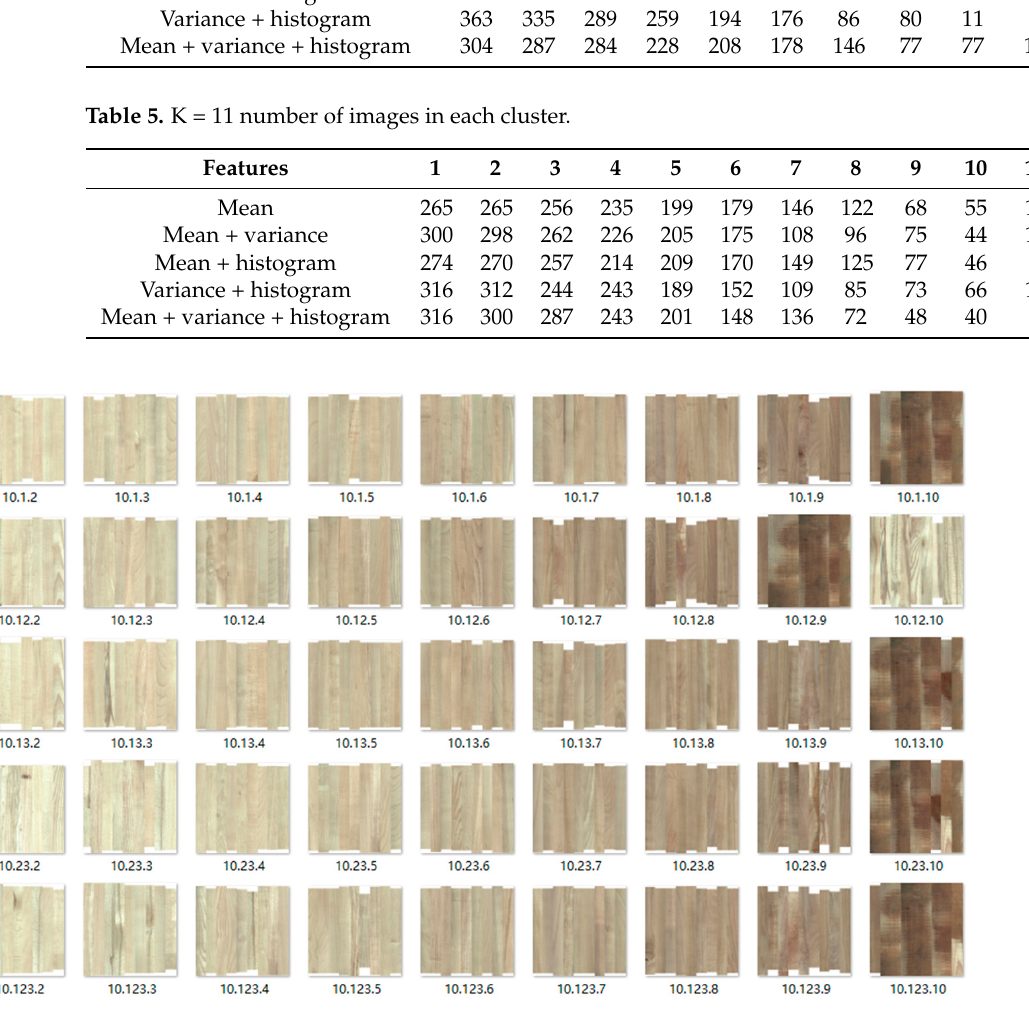
Figure 9. K = 10 clustering result images.